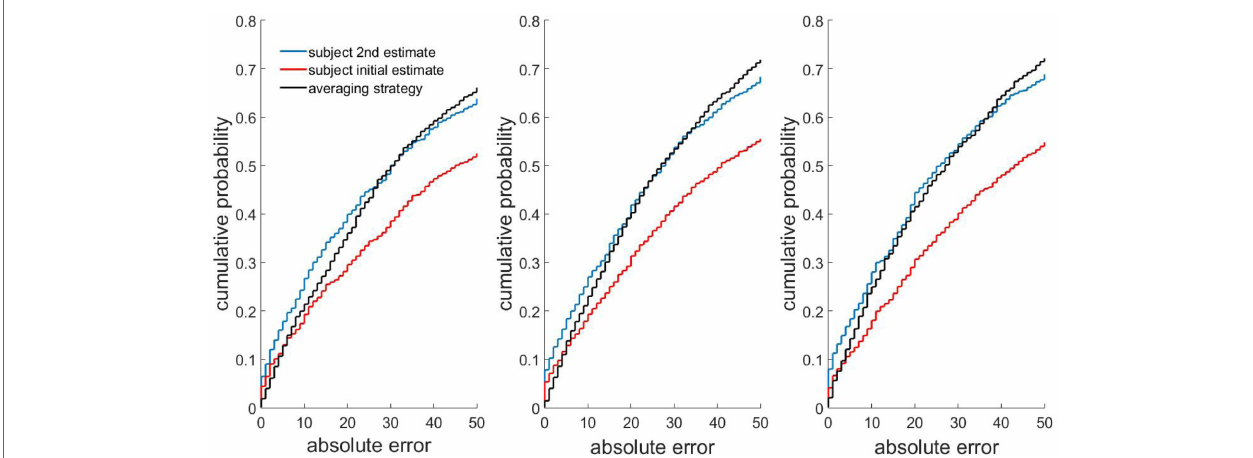
FIGURE 6 | Errors in human advice-taking strategy compared to the averaging strategy. The cumulative distribution of errors of three advice-taking strategies for 2, 4, and 8 advisers. Red curve: initial subject opinion. Blue curve: subject opinions after hearing advice from 2 (left), 4 (middle), or 8 (right) randomly chosen fellows. Black curve: averaging strategy, which calculates a final estimate mechanically by averaging a subjects initial opinion together with all advisers opinions. Data from Yaniv and Milyavsky (2007).